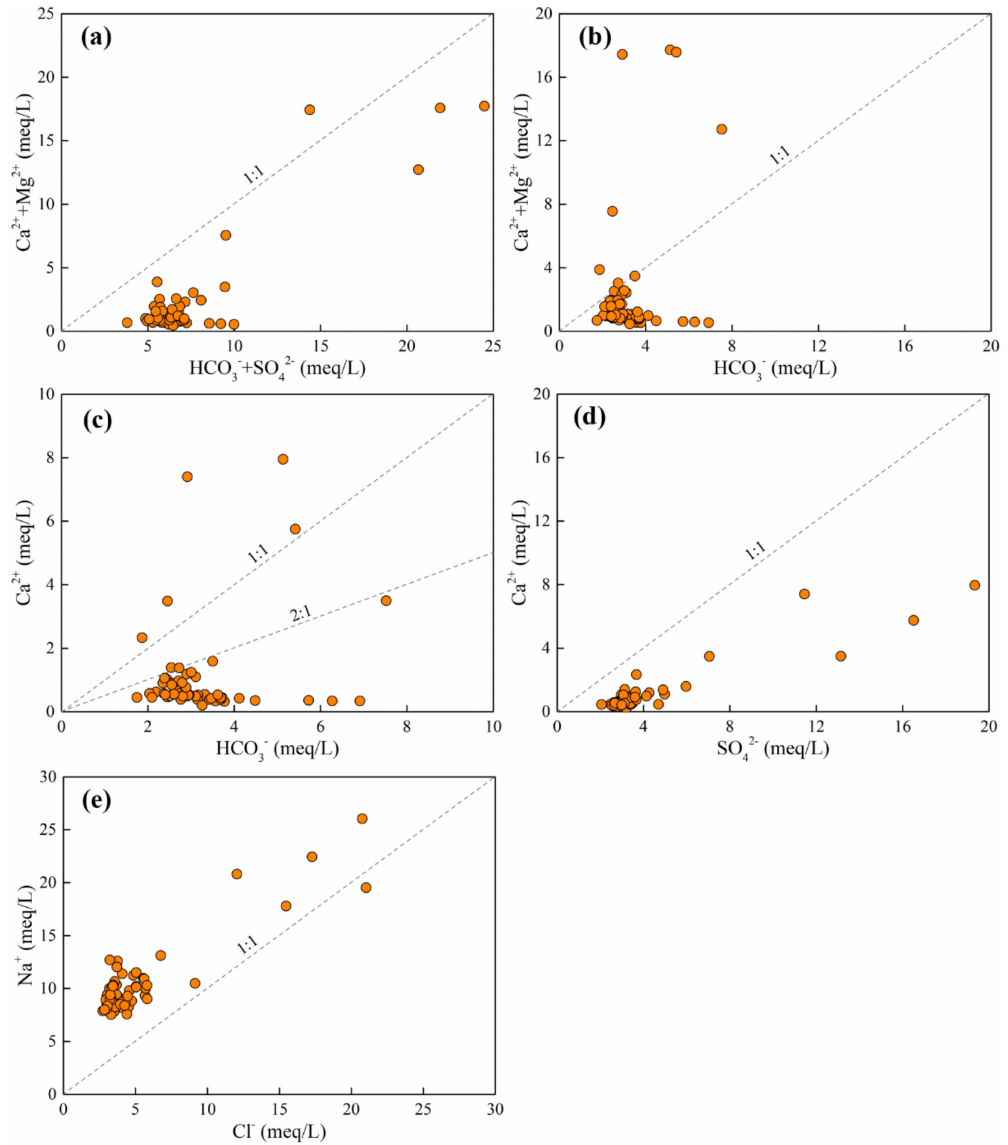
Figure 11. Scatter plots of ( a ) Na + versus Cl − , ( b ) Ca 2 + versus SO 42 − , ( c ) Ca 2 + versus HCO 3 − , ( d ) Ca 2 + + Mg 2 + versus HCO 3 − , and ( e ) Ca 2 + + Mg 2 + versus HCO 3 − + SO 42 − of